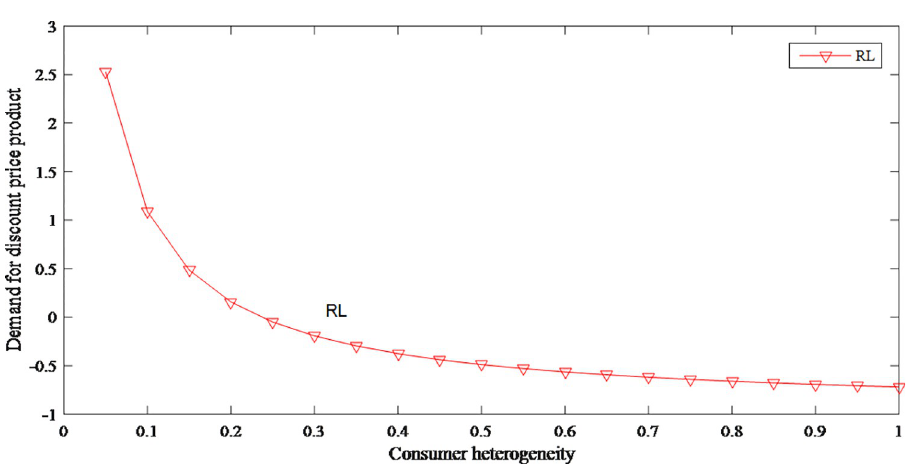
Fig 17. The impact of consumer heterogeneity on demand for discount price product. https://doi.org/10.1371/journal.pone.0279334.g017 PLOS ONE | https://doi.org/10.1371/journal.pone.0279334 January 18,